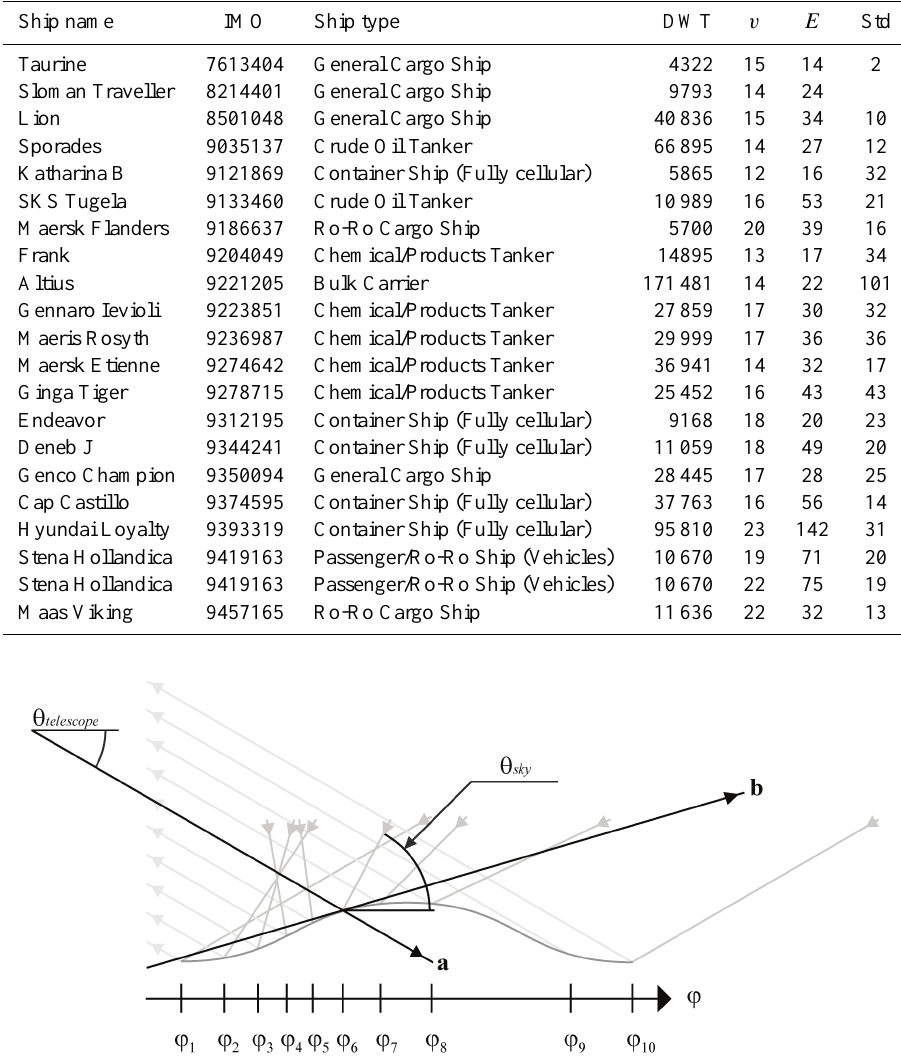
Fig. 10. Illustration of sky light scattering on a sinusoidal wave surface. Parallel rays with the angle of the telescope are used to calculate the incoming sky light angle. Vector a originates from the telescope towards the wave, at the telescope angle, and vector b is in the direction of the tangent were vector a crosses the wave. Equation (8) gives the incoming sky light